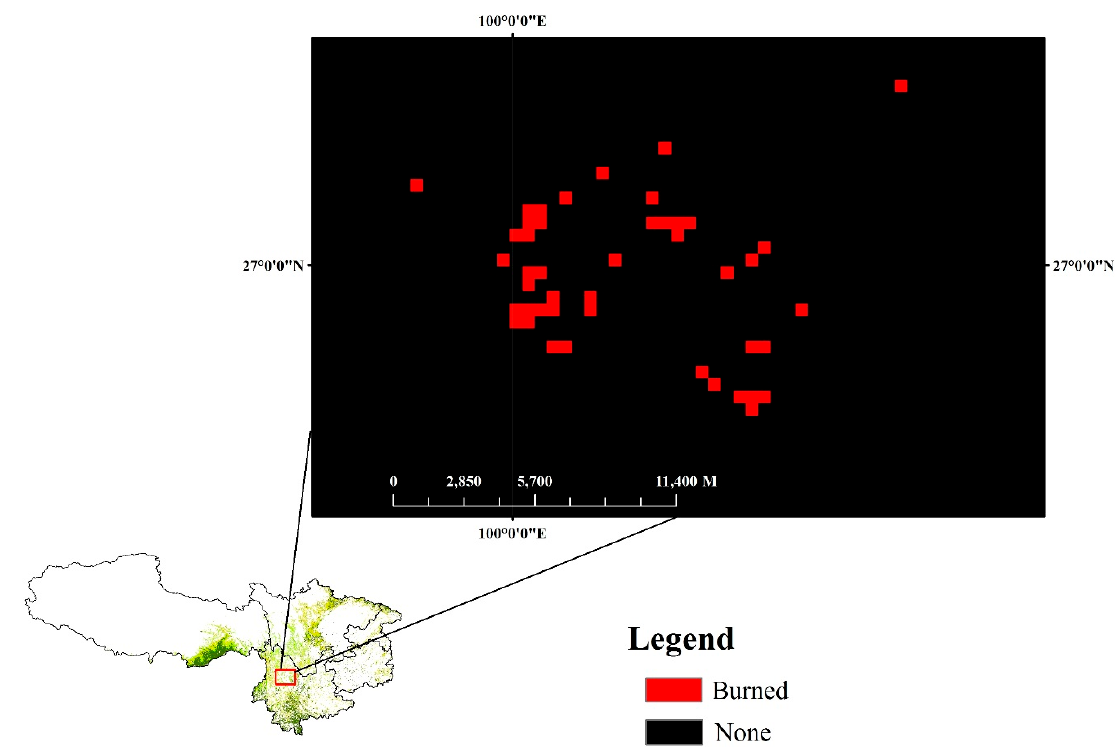
Figure 2. The forest burned area grids in southwest China in 2013.